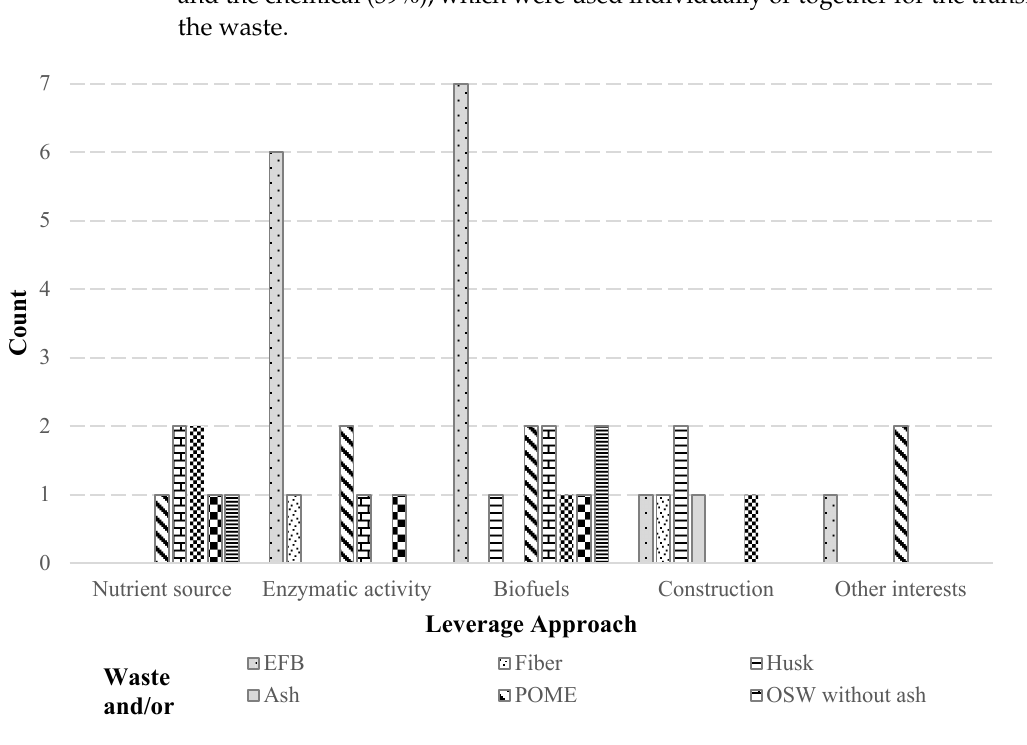
Figure 3. Concentration of technological approaches for the valuation of palm oil waste and/or by-product.